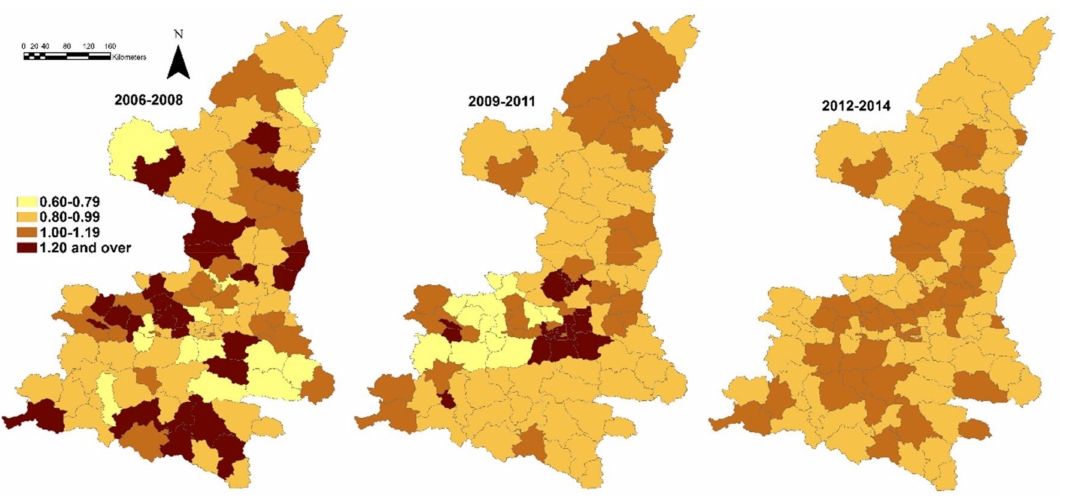
Figure 3. Spatial random effect for JE incidence (2006–2014), structured spatial residuals with fixed effect in Model